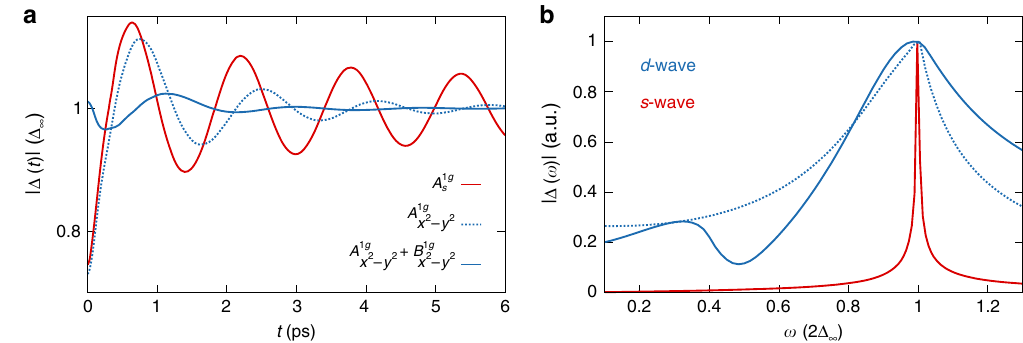
Fig. 3 Higgs oscillations of a d - wave superconductor . a Numerical simulation of the Higgs oscillations induced by various quench symmetries for a (cid:3) 1 ( f q (cid:3) x 2 (cid:1) y 2 ) quench as a function of time. The red solid d x 2 (cid:1) y 2 -wave superconductor. The solid (dotted) blue line shows the gap oscillations after a f q k k (cid:3) 1 quench for an s -wave superconductor for comparison. b Fourier spectrum j Δ ð ω Þj ¼ j FT j Δ ð t Þjj of the Higgs oscillations. The oscillation line shows an f q k (cid:3) x 2 (cid:1) y 2 quench shows a single peak, similar to the s -wave case. The peak position corresponds to 2 Δ for the d -wave gap excited by the f q 1 , which is two k (cid:3) 1 quench, a second peak at low energy appears resulting from B 1 g times the maximum of the gap for t ! 1 after the quench. For the f q oscillations of k x 2 (cid:1) y 2 the